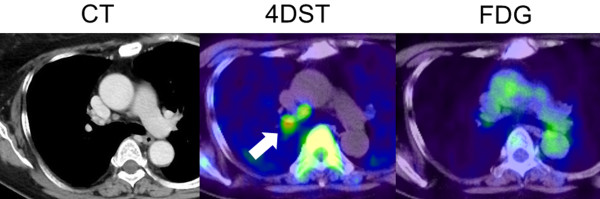
PET findings with 4DST and FDG for lymph node lesions and primary lung cancer in patient no. 16. Focal 4DST uptake is confirmed at the right lower paratracheal lymph node (#4R), which is not identified by FDG. The lesion was a histopathologically proven lymph node metastasis.